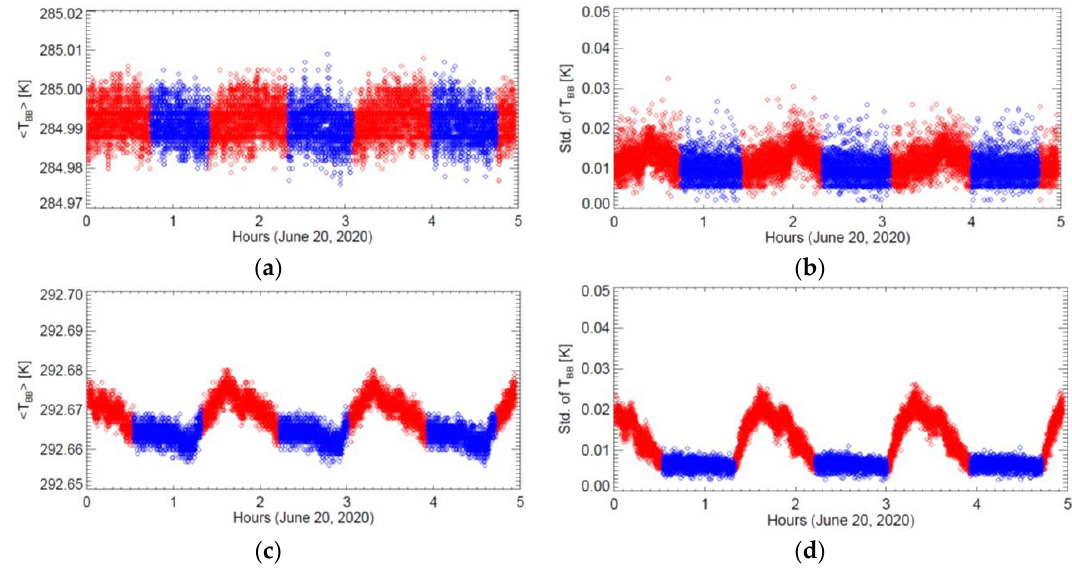
Figure 11. Aqua MODIS ( a ) and ( b ) and S-NPP VIIRS ( c ) and ( d ) blackbody (BB) temperatures (average over all thermistors) and standard deviations. Red color: daytime orbit data; Blue color: nighttime orbit data" at the end of current figure caption.